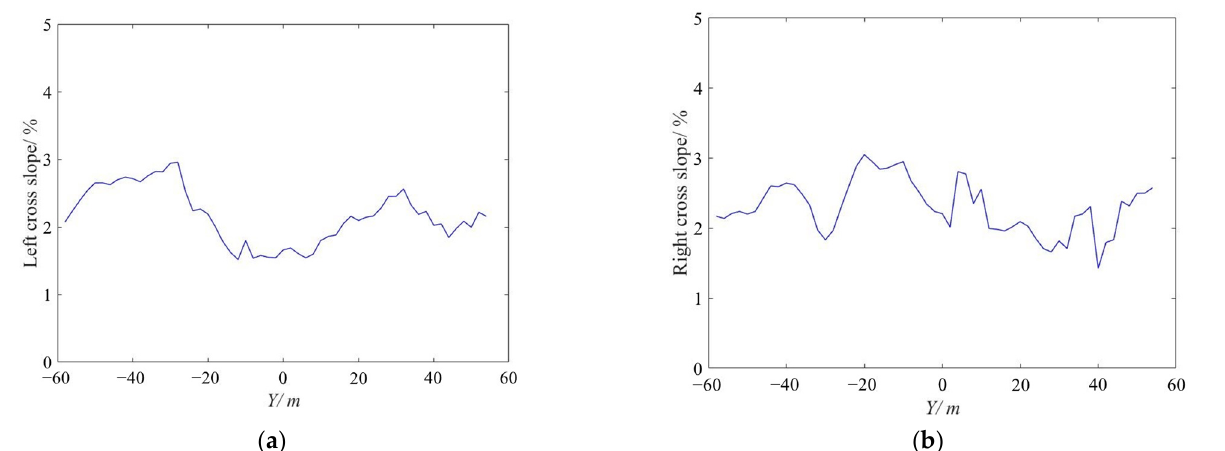
Figure 13. Road width.